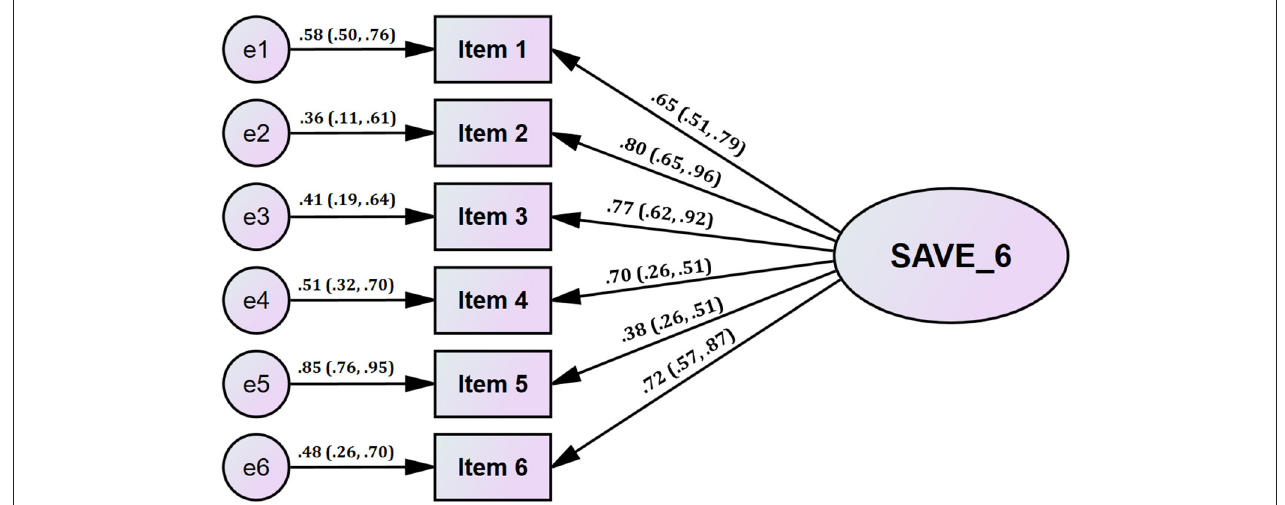
FIGURE 1 | Factor structure of the SAVE-6 scale among healthcare workers in Spain.